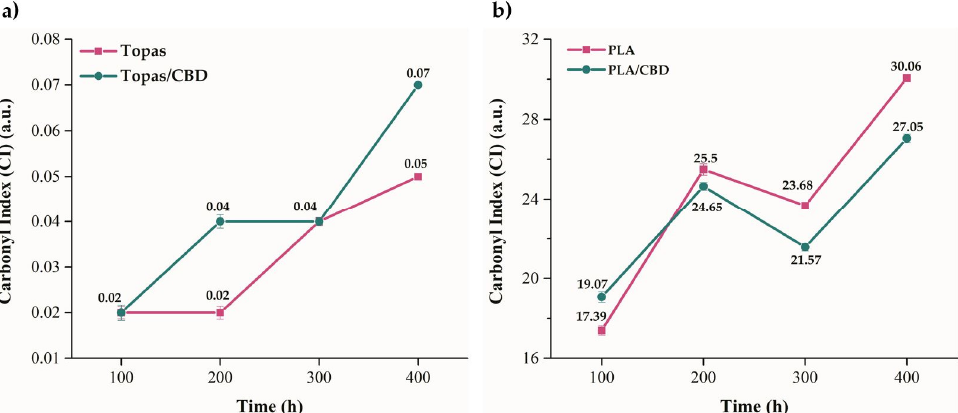
Figure 4. Carbonyl index (CI) values obtained ( a ) for ethylene-norbornene copolymer (Topas) and ( b ) polylactide (PLA) mixtures after weather-aging, where C=O groups were observed within the 1600–1800 cm − 1 range and CH groups at 2915 and 2946 cm − 1 , respectively.